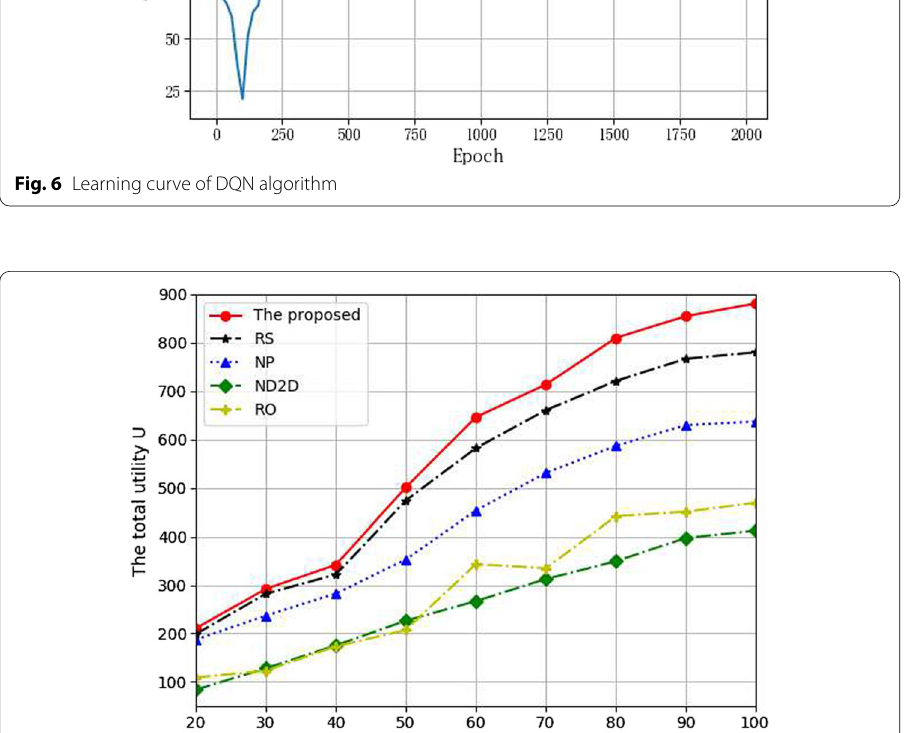
Fig. 7 The total utility of UEs over the number of